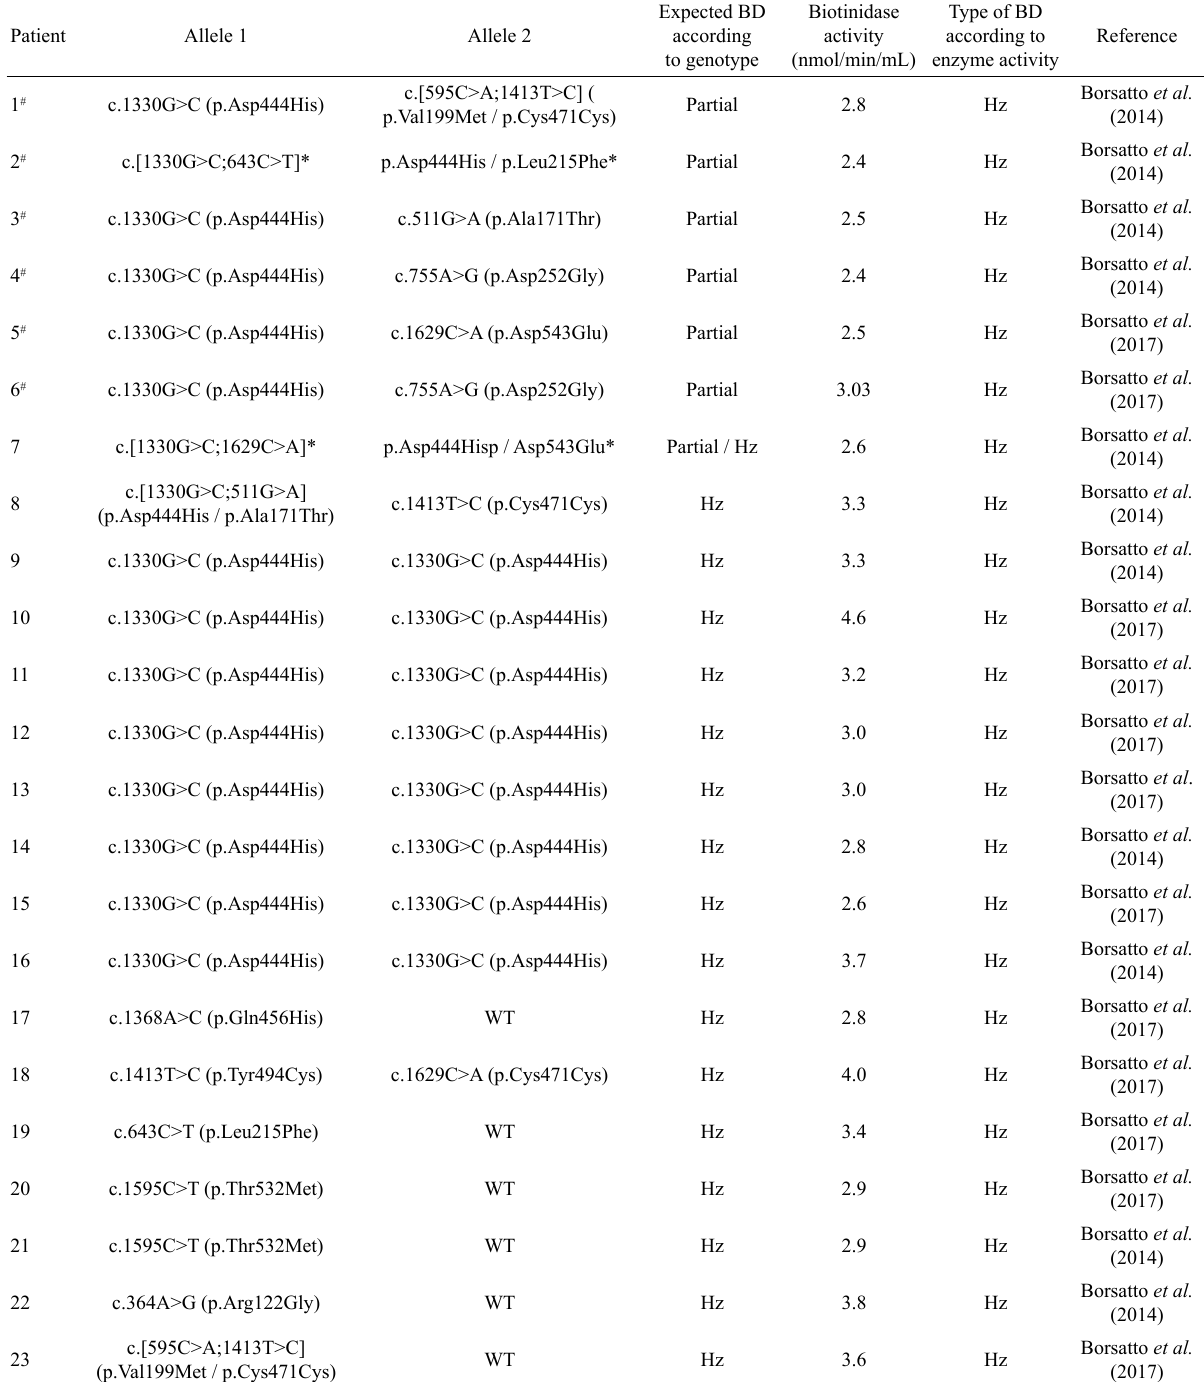
Table 1 – Genetic and biochemical profile of patients with reduced biotinidase activity included in the characterization of the 3’UTR. Patient Allele 1 Allele 2